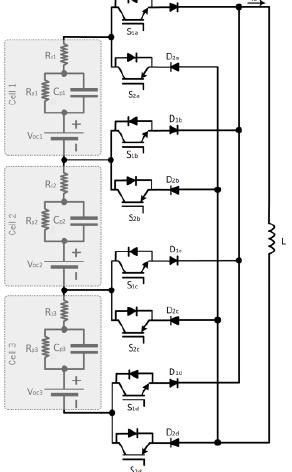
Figure 9. Single inductor converter.